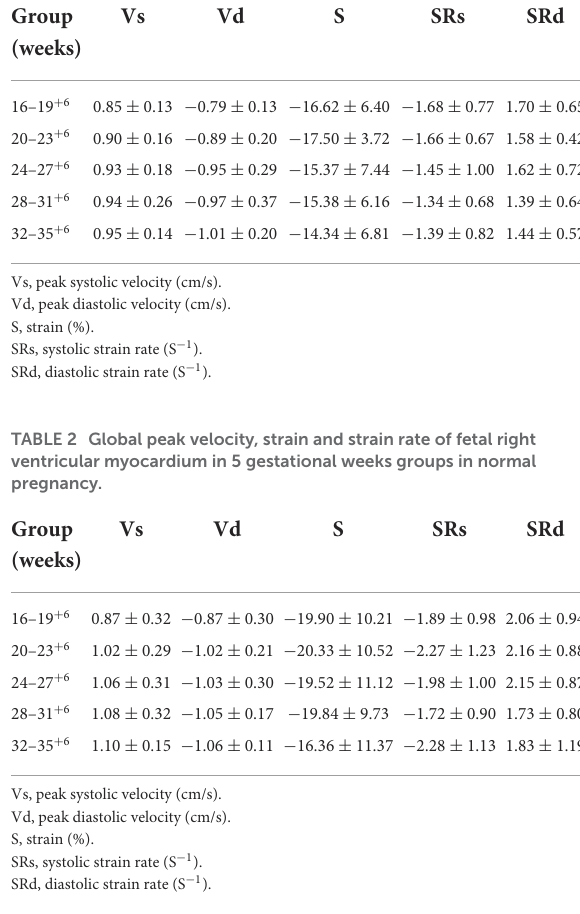
TABLE 1 Global peak velocity, strain and strain rate of fetal left ventricular myocardium in 5 gestational weeks groups in normal pregnancy.